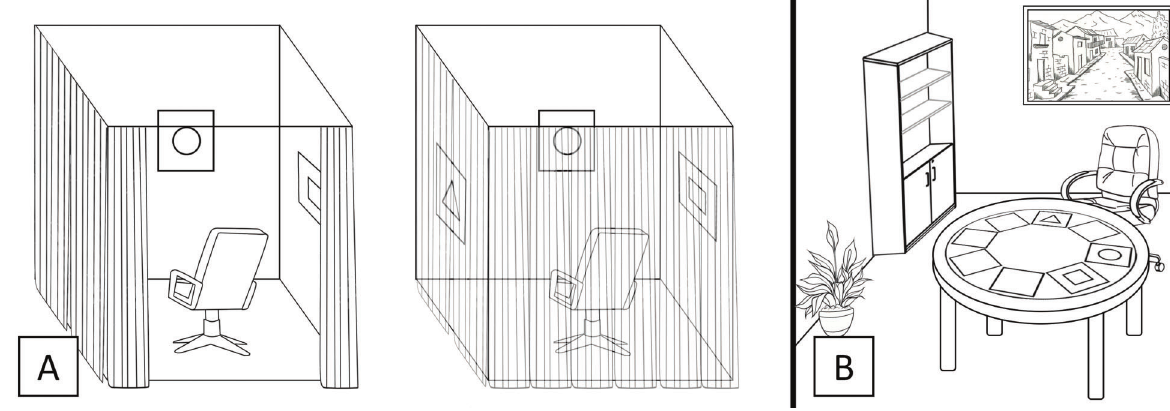
Figure 1. Representation of the experimental conditions of the Egocentric Spatial Memory Task ( A ) and the Allocentric Spatial Memory Task ( B